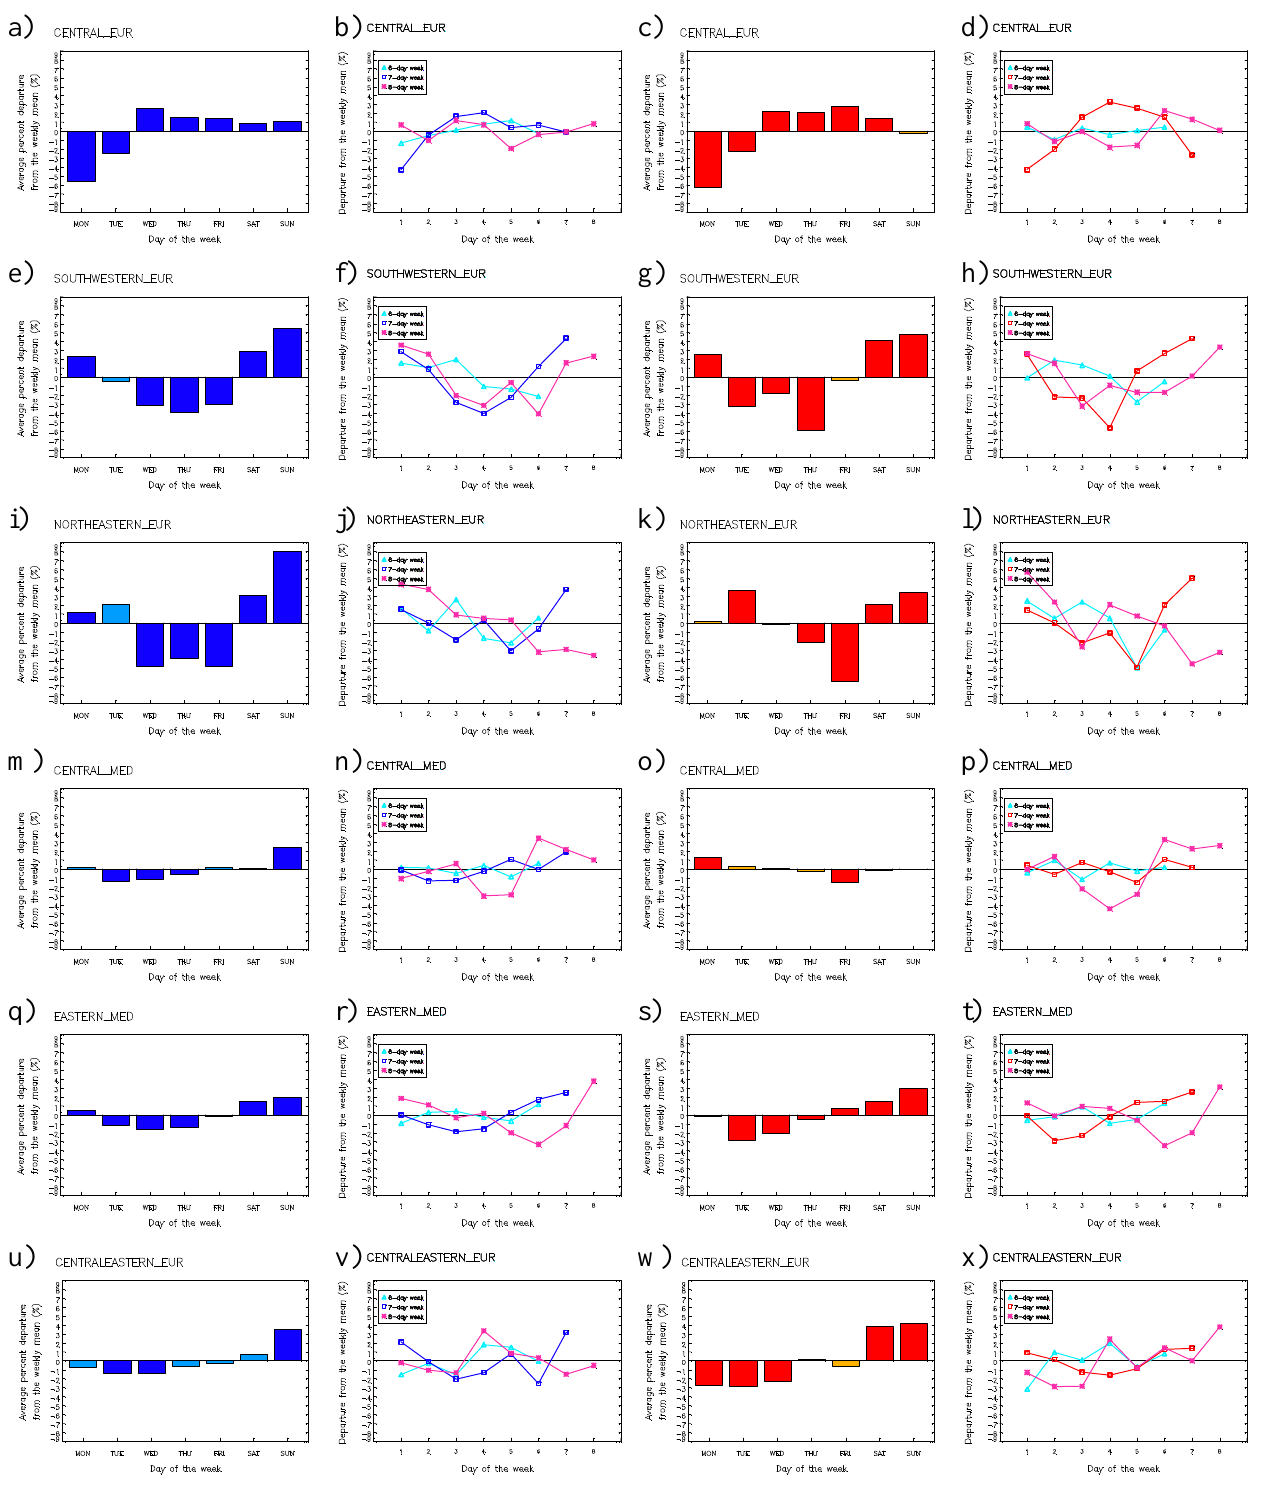
Fig. 4. Weekly variability of (a) spatially averaged APDs calculated using TERRA MODIS (blue bars) AOD 550 grid measurements for the period February 2000–February 2009 for CE (APDs that are not statistically different than zero at the 90% confidence level according to a two-tailed t-test are indicated with a light blue bar), (b) APDs calculated from the CE spatially averaged time series for 7 (blue), 6 (light blue) and 8-day (magenta) weeks (TERRA MODIS), (c) spatially averaged APDs calculated using AQUA MODIS (red bars) AOD 550 grid measurements for the period July 2002–December 2008 for CE (APDs that are not statistically different than zero at the 90% confidence level according to a two-tailed t-test are indicated with a yellow bar), (d) APDs calculated from the CE spatially averaged time series for 7 (red), 6 (light blue) and 8-day (magenta) weeks (AQUA MODIS), (e, f, g, h) the same as (a, b, c, d) but for SWE, (i, j, k, l) the same as (a, b, c, d) but for NEE, (m, n, o, p) the same as (a, b, c, d) but for CM, (q, r, s, t) the same as (a, b, c, d) but for EM, (u, v, w, x) the same as (a, b, c, d) but for